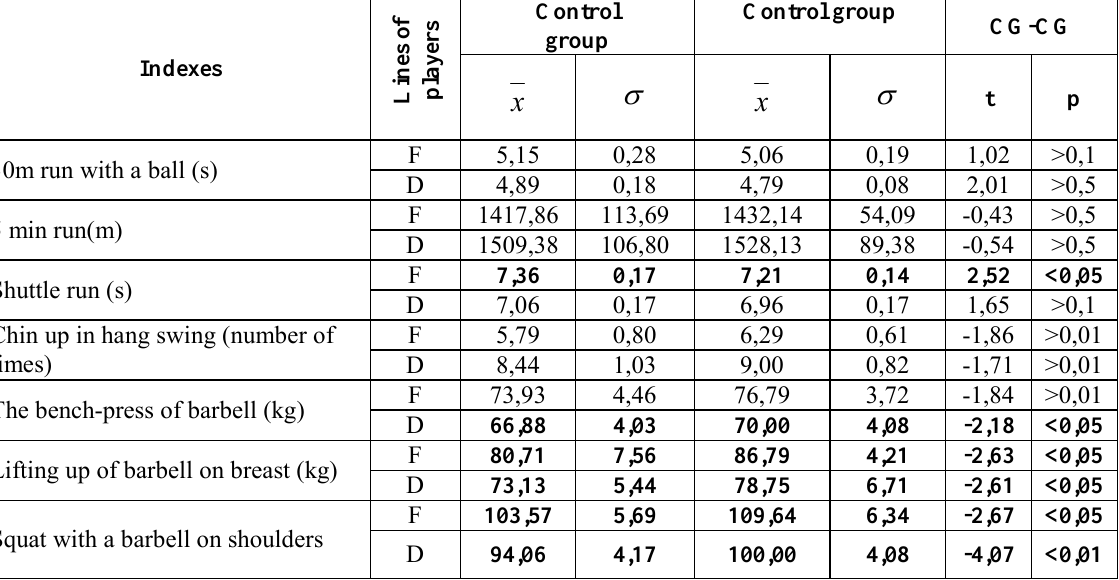
Comparison of indexes of the special physical preparedness on the preliminary stage of experiment and first stage of experiment of control group (n=30) of rugby-players aged 16-17 years